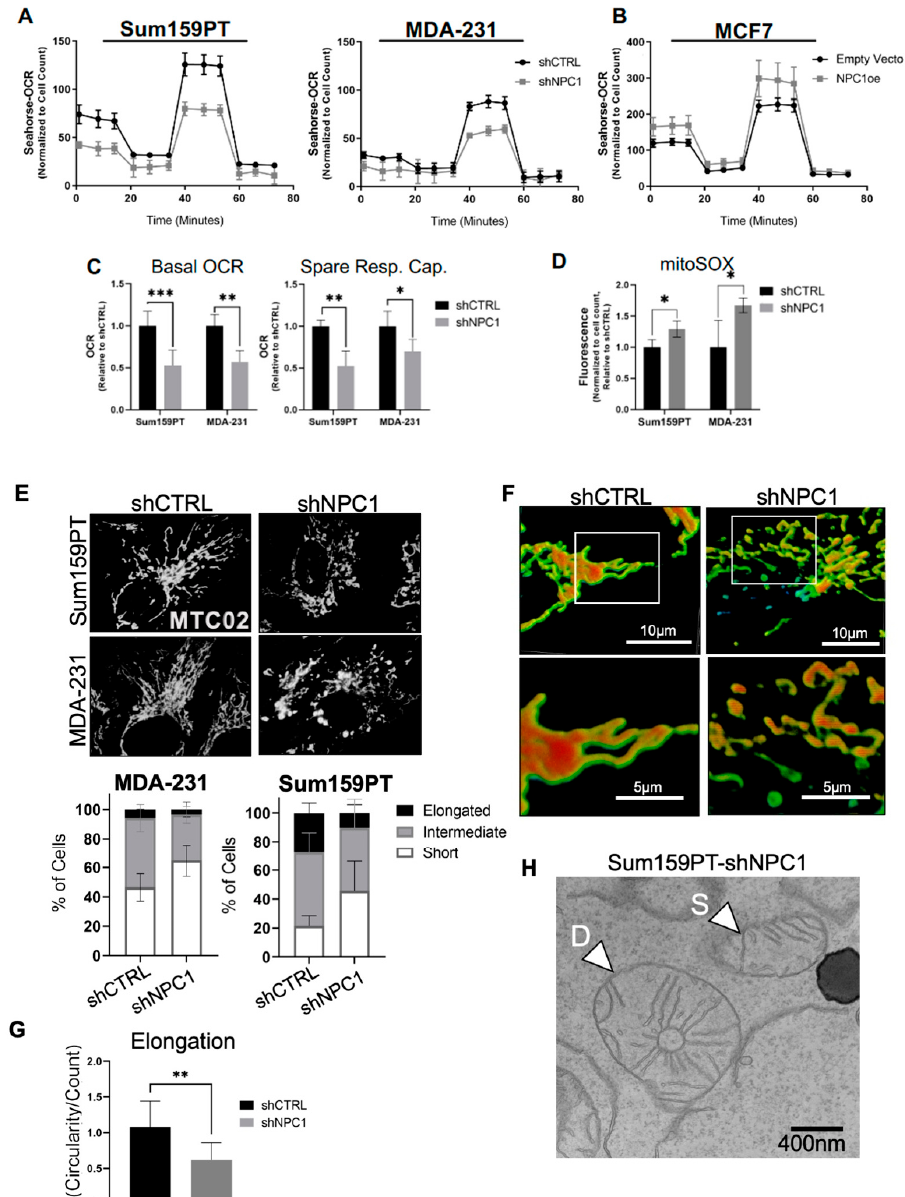
Figure 4. NPC1 supports mitochondrial respiration and maintains mitochondrial morphology. ( A ) Oxygen consumption rate (OCR) during Seahorse mitochondrial stress test, performed on Sum159PT and MDA-231 cell lines with NPC1 knockdown. ( B ) Mitochondrial stress test performed on MCF7 with pcDNA3.1-NPC1 or an empty vector. ( C ) Quantification of basal OCR and spare respiratory capacity of TNBC cells from mitochondrial stress test shown in A. ( D ) Mitochondrial ROS was evaluated using mitoSox staining. ( E ) Top: Representative images of fluorescence microscopy of TNBC cells stained with MTC02 (mitochondrial antibody). Bottom: quantification of cells with mitochondrial morphology defined as either elongated, intermediate, or short. ( F ) Confocal Z-stacking of mitochondria stained with MTC02, with representative images of ”elongated” (shCTRL) versus “shortened” (shNPC1) mitochondria. A snapshot of 60× with 4× zoom (top panel), and 60× with 8× zoom (bottom panel). ( G ) Quantification of mitochondrial elongation, as quantified by ImageJ. ( H ) Representative transmission electron microscopy image of short (“S”) and donut (“D”) mitochondria in Sum159PT with shNPC1 (30,000×). p -values denoted by asterisks where * ≤ 0.05; ** ≤ 0.01; *** ≤ 0.001.